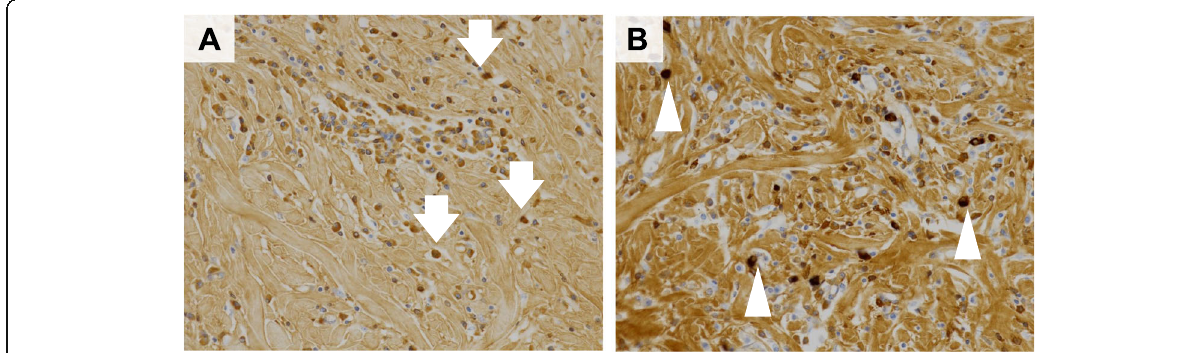
Fig. 3 Immunological examination showed IgG-positive cells ( a , arrows) and IgG4-positive cells ( b , arrowheads) in the gastric